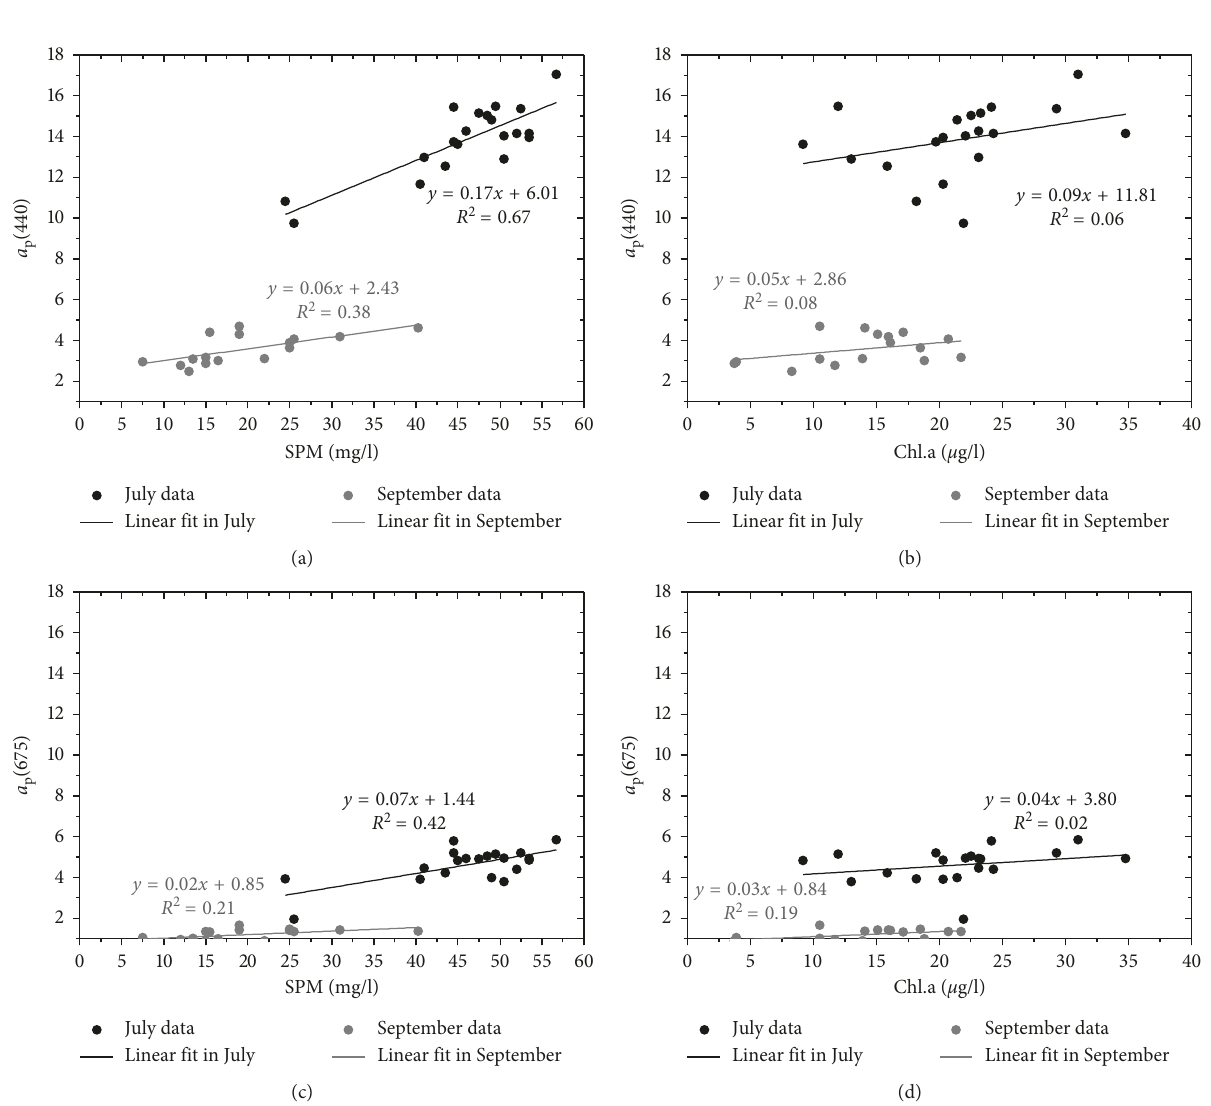
Figure 3: The linear relationships of a p (440) and a p (675) with SPM and Chl.a